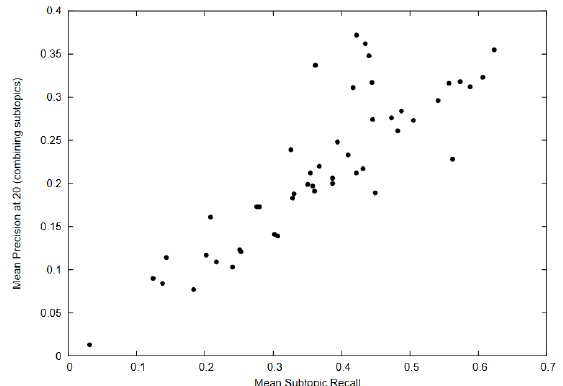
Figure 7. Effective systems are effective whatever the measure used. Web track 09 participants’ results considering mean subtopic recall (X-axis) and mean precision (Y-axis); each dot is a participant systems. Figure reprinted with permission from [43], Copyright 2009, Charles Clarke et